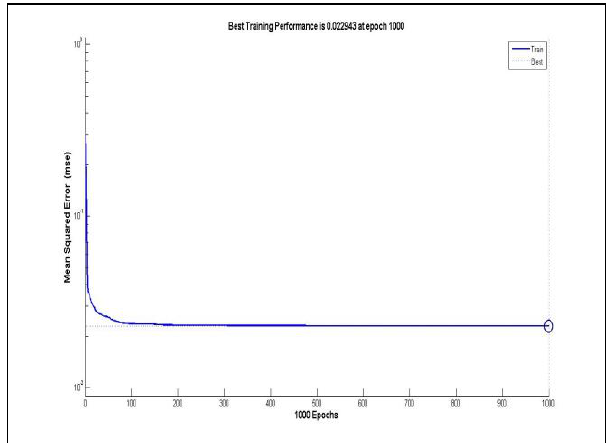
Figure 8. Procedure of convergence Comparison between the real values of the traffic and the results obtained from the network are presented in Figure 9. The red cycles are the training data and the blue squares are the output training data of the neural network.